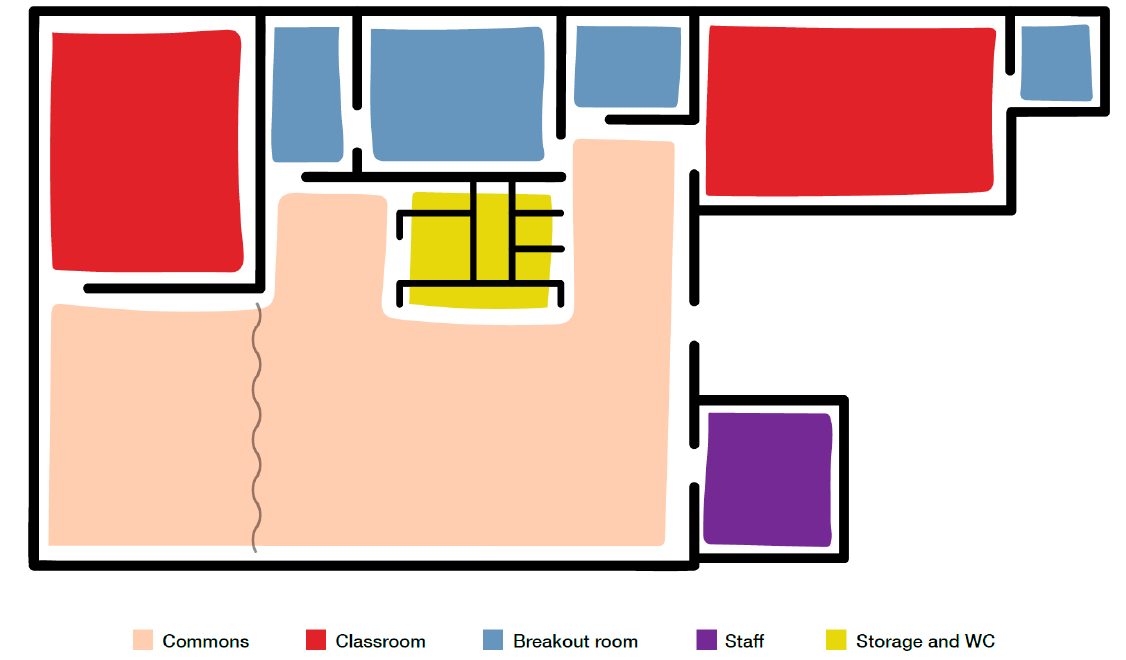
Figure 1. Team learning environment in Hill School.